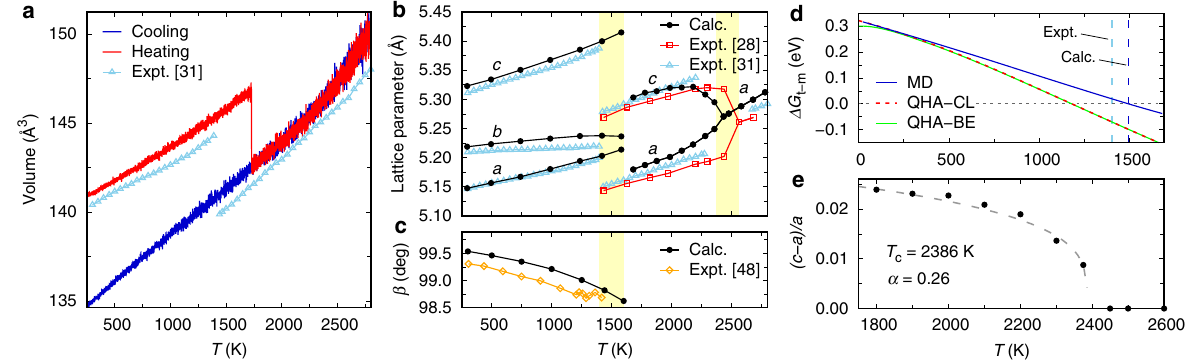
Fig. 4 Phase transitions of ZrO 2 from MD simulations and thermodynamic integration. a Evolution with temperature of the unit-cell volume during a heating and cooling simulation of a 324 atom supercell. b , c Temperature dependence of b the lattice parameters and c the monoclinic angle β from NPT simulations. Experimental data from refs. 28,31,48 are also reported. In a the moving average over blocks of 2000 time steps is shown. The yellow areas in b , c highlight the difference between the experimental transition temperatures and the ones from direct MD simulations. The phase transitions are studied in more detail in d , showing the difference between the free energy per unit cell of the tetragonal and monoclinic phase Δ G t − m as a function of temperature, and e displaying the tetragonal distortion ( c − a )/ a and its fi t to the function ð T c (cid:2) T Þ α . In d the data from our fully anharmonic MD calculations are reported, as well as from the QHA using classical (CL) and quantum (BE) statistics. The dashed vertical lines indicate the experimental and calculated temperature of the martensitic transformation.